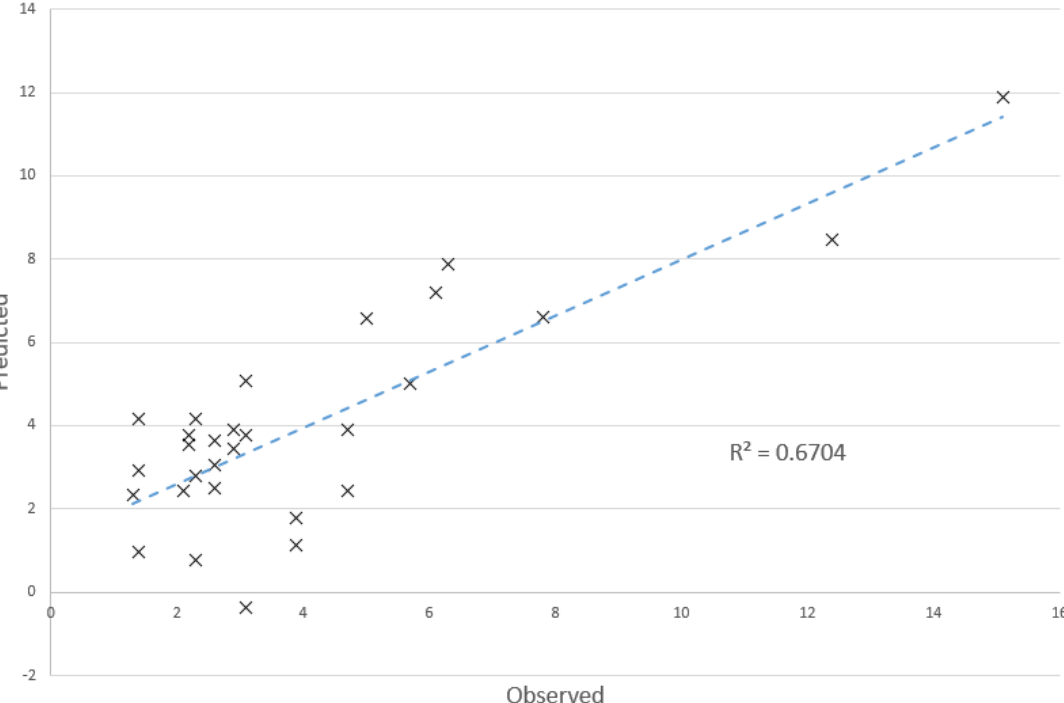
Table 5. Statistical results of SOM and the RUSLE correlation